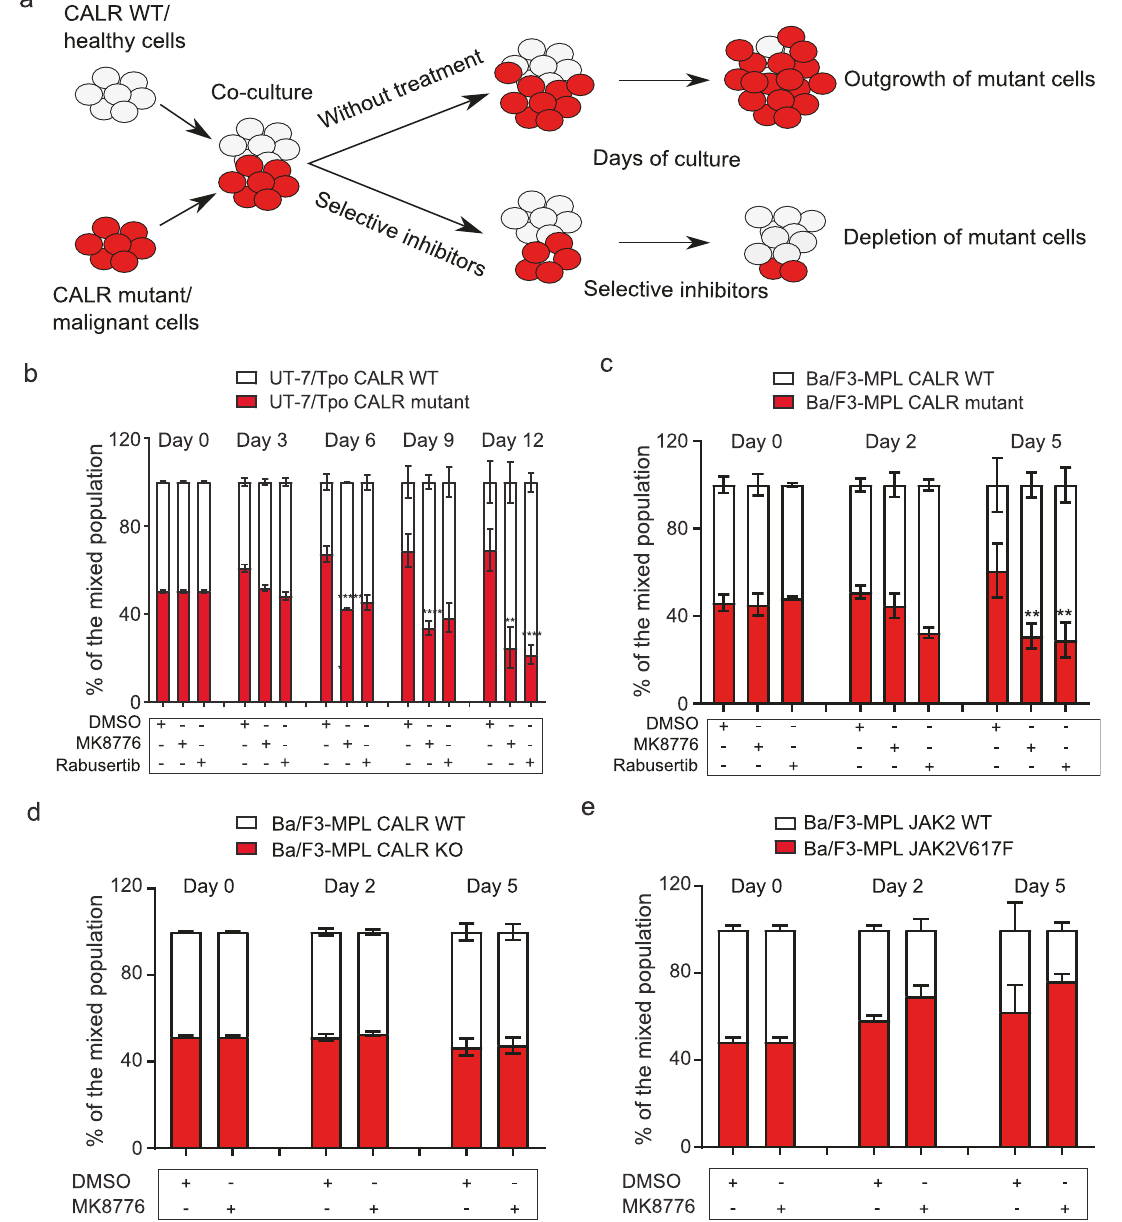
Fig. 2 CHK1 inhibitors selectively reduce the proliferation of cells carrying oncogenic CALR. a Schematic diagram of the setup of the co- culture competition assay. b UT-7/Tpo CALR wild type and del61/WT cell line were incubated with 0.8 µM of CHK1 inhibitor rabusertib or 1 µM of MK8776 over 12 days. Wild type (mCherry negative) and mutant cells (mCherry positive) were mixed at a 1:1 ratio and 1% of TPO conditioned media was present. Samples were collected every three days and the ratio of wild-type cells to mutant cells was measured by FACs analysis. c Ba/F3-MPL CALR wild type and del37/del37 cell line were incubated with 0.8 µM rabusertib or 1 µM MK8776 over 5 days. Wild type (mCherry negative) and mutant cells (mCherry positive) were mixed at a 1:1 ratio and 1% of TPO conditioned media was present. Samples were collected at day 0, day 2, and the end of treatment. The ratio of wild-type cells to mutant cells was measured by FACs analysis. d Ba/F3-MPL CALR wild type and CALR knockout cell line were incubated with 1 µM MK8776 over 5 days in a co-culture competition assay. e Ba/F3-MPL JAK2 wild type and JAK2V617F mutated cell lines were incubated with 1 µM MK8776 over 5 days in a co-culture competition